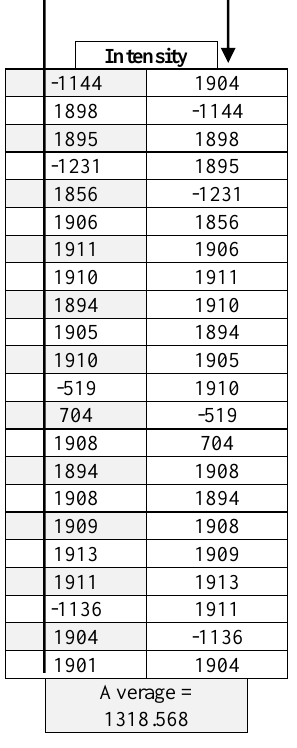
Table 3: Intensity values of the target surface The Scans are carried out in high resolution which amounts to approximately 25 million points in a single scan session. The same object in two different scans has been compared to analyse detail difference between two sessions and the amount of detail points on the objects has been analysed and compared to determine if there is any reduction in detail level between day and night conditions (Figure 5)